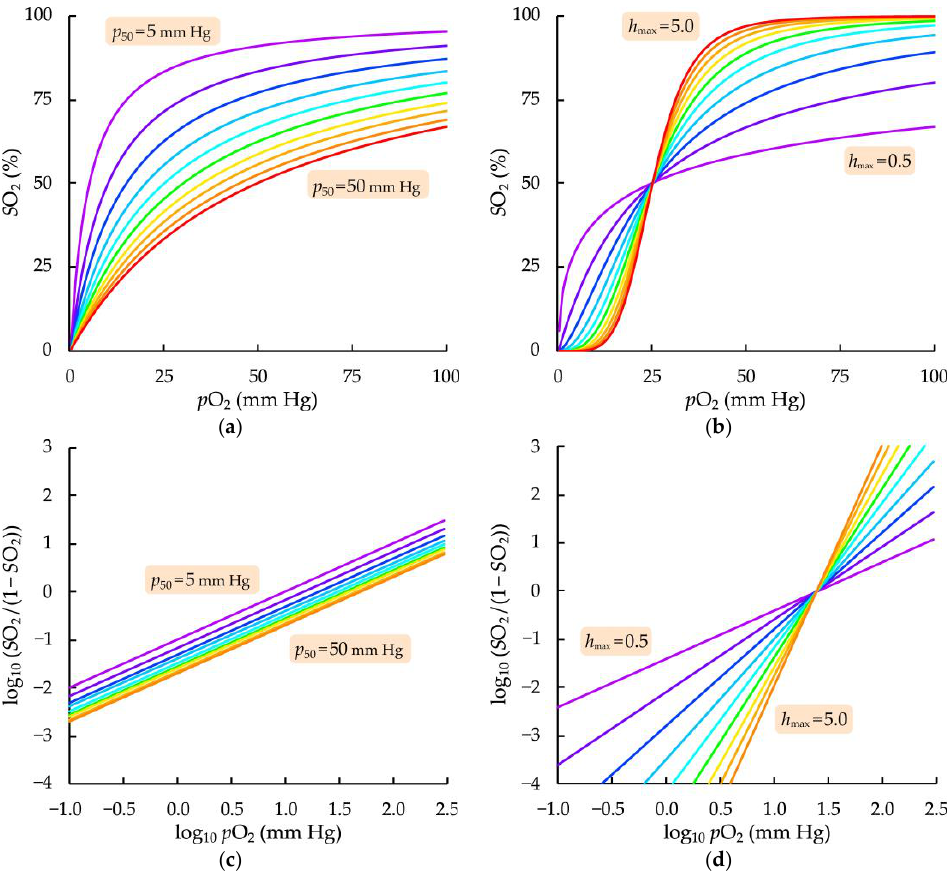
Figure 3. Dependence of the model oxyhemoglobin dissociation curve: ( a , c ) at constant parameters: h max , p max , s , and variable p 50 ; ( b , d ) at constant parameters: p 50 , p max , s , and variable h max ; axes: p O 2 , partial pressure of oxygen; S O 2 , oxygen saturation.